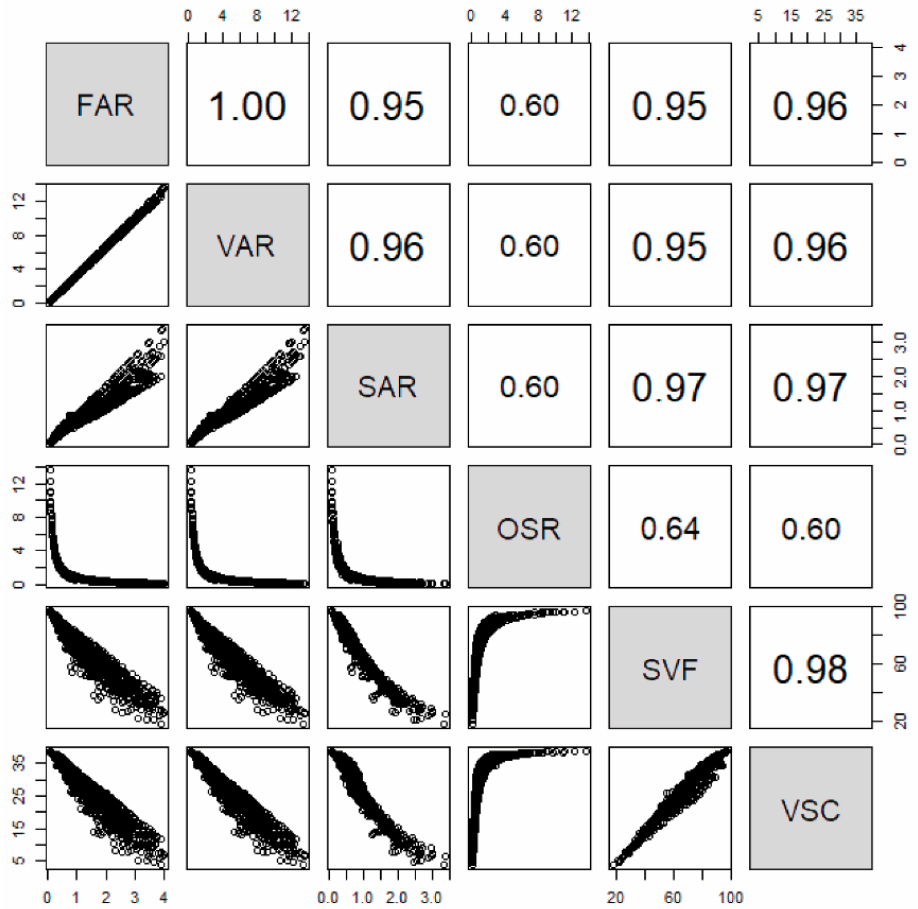
Figure 12. Summary of pairwise relationships between G-metrics with graphical plots (lower half) and Pearson correlation results (upper half).